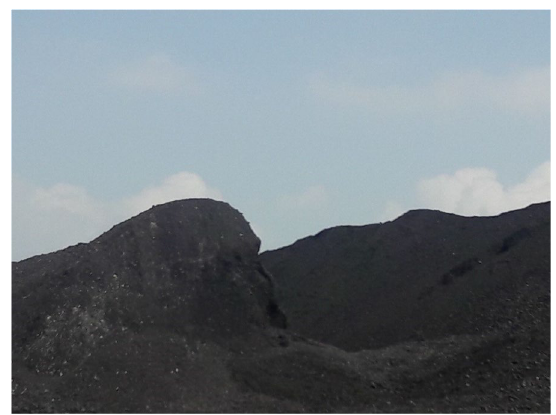
Fig. 1 Surface of coal yard in Norocholai